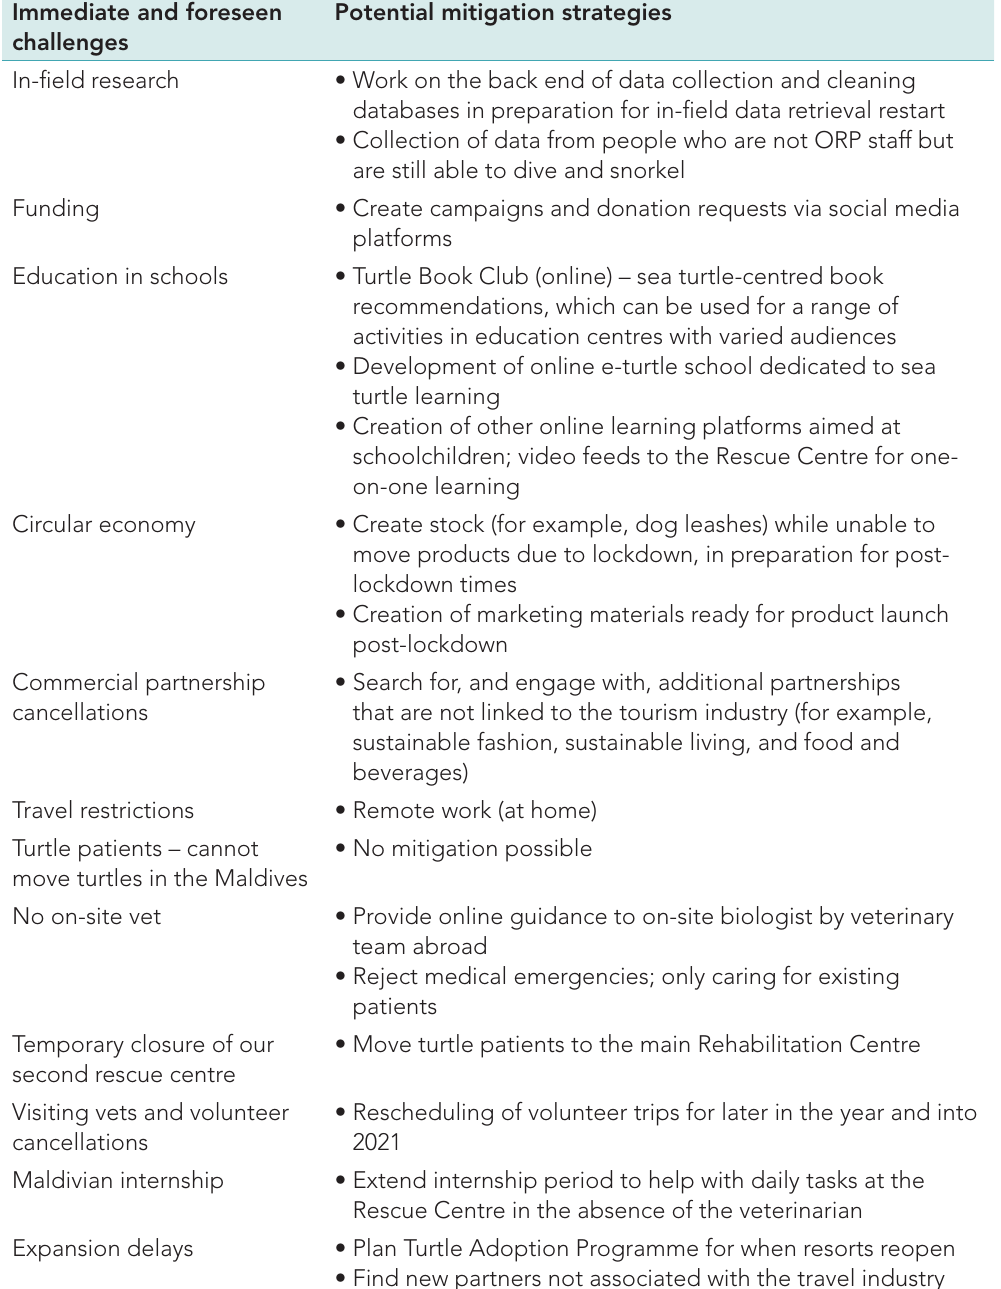
Table 2: challenges and impacts originated by coVID-19 on the oRP network and potential strategies to mitigate